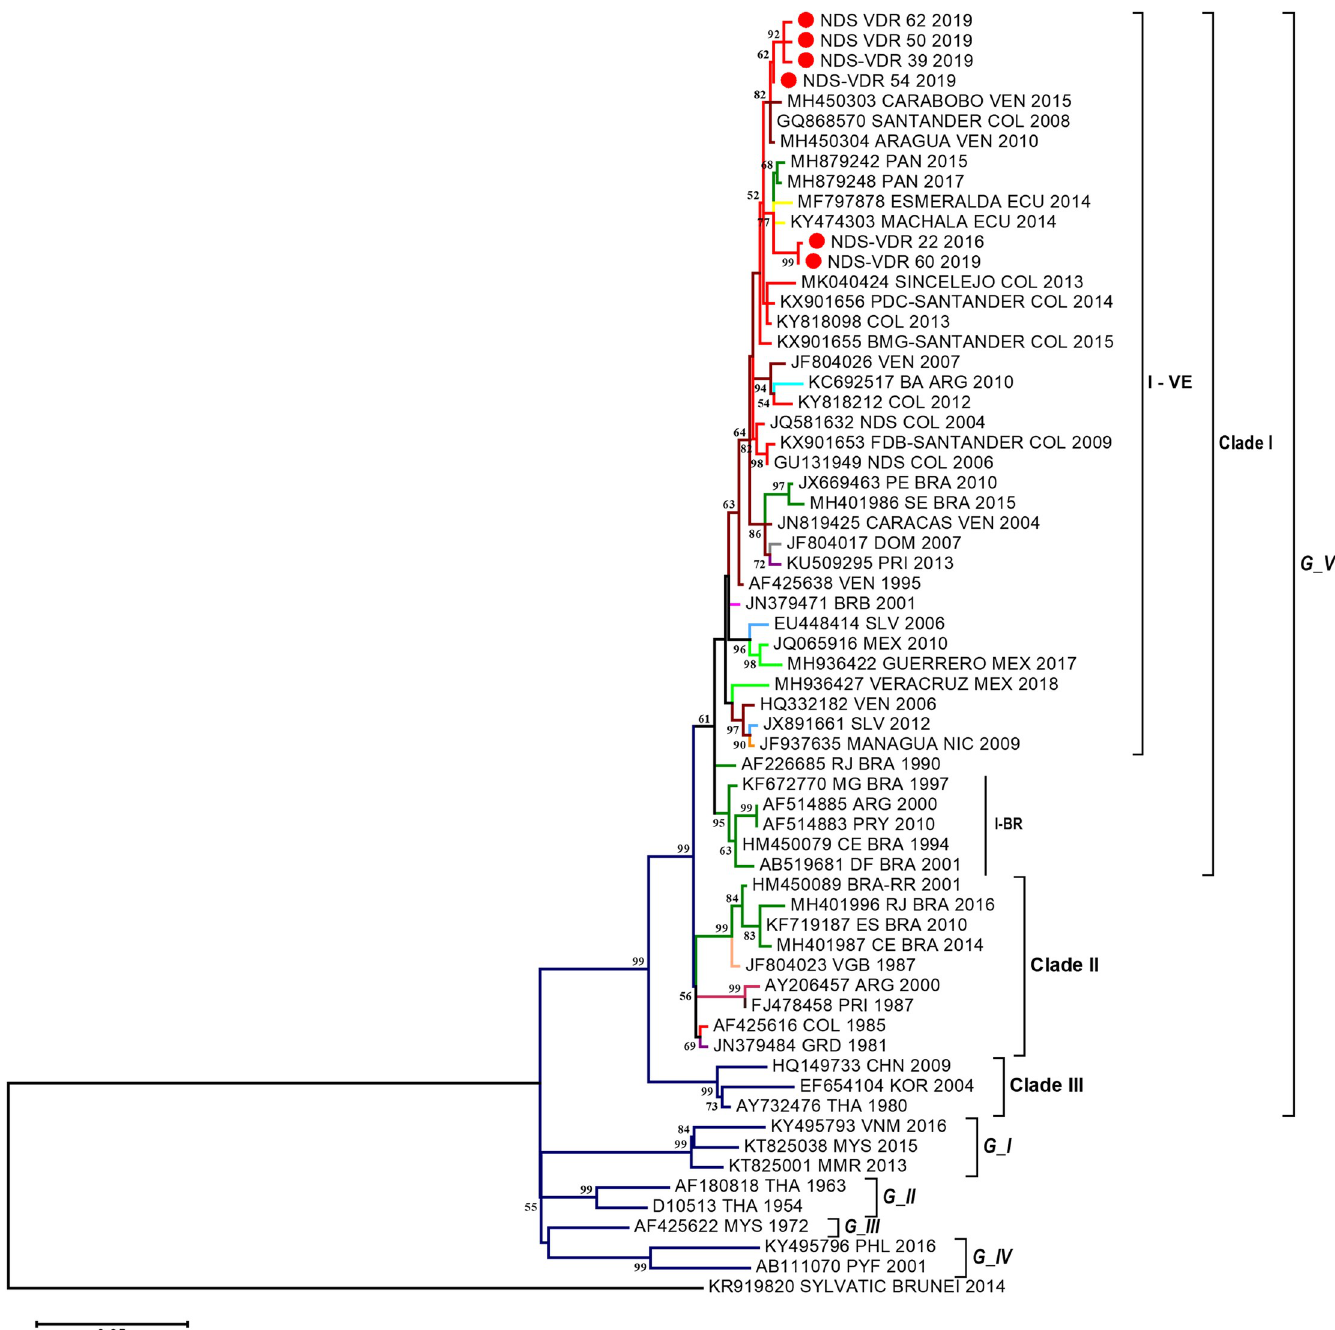
Fig 2. Phylogenetic analysis of DENV-1 strains. The analysis was conducted using the maximum likelihood method based on the Envelope gene using 6 sequences of 945 nt length and 131 sequences that have been previously deposited in GenBank. The tree was reconstructed using the nucleotide replacement model TN93 + G + I. The red circles represent the sequences from Norte de Santander identified as NDS-VDR. G: Genotype, BR: Brazil and VE: Venezuela. Color Code: Red: Colombia, red wine color: Venezuela, Blue: Argentina, Light Blue: Dominican Republic, green: Brazil, yellow: British Virgin Islands, and purple: Asian sequences.